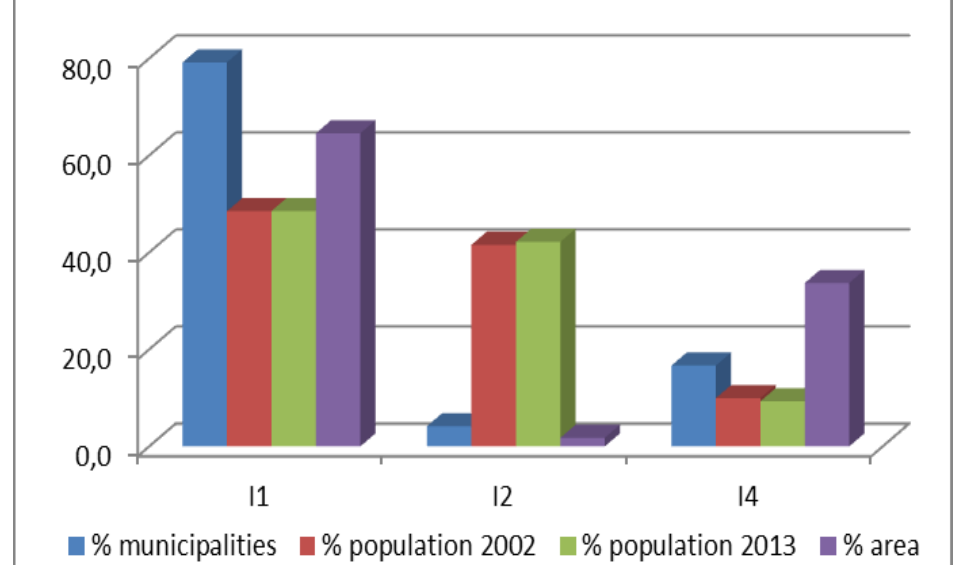
Fig. 6. Distribution of municipalities, population and areas in the immigration areas, in % (calculated by the authors, according to SSORM data)